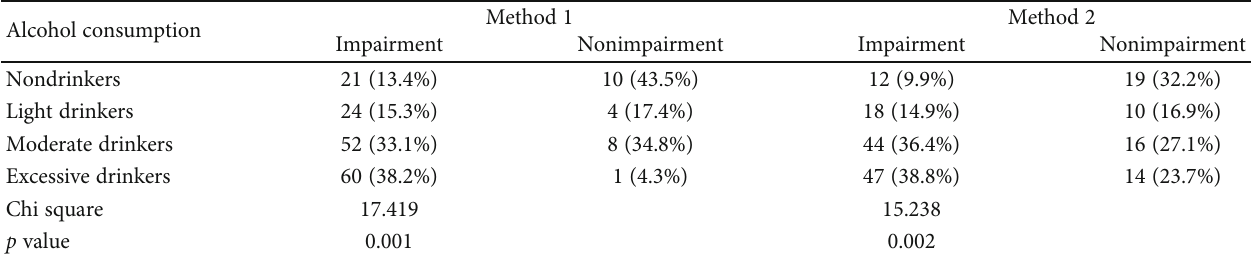
Table 3: Comparison of alcohol consumption between the cognitive impairment and nonimpairment groups according to two di ff erent Montreal Cognitive Assessment (MoCA) cuto ff scores.